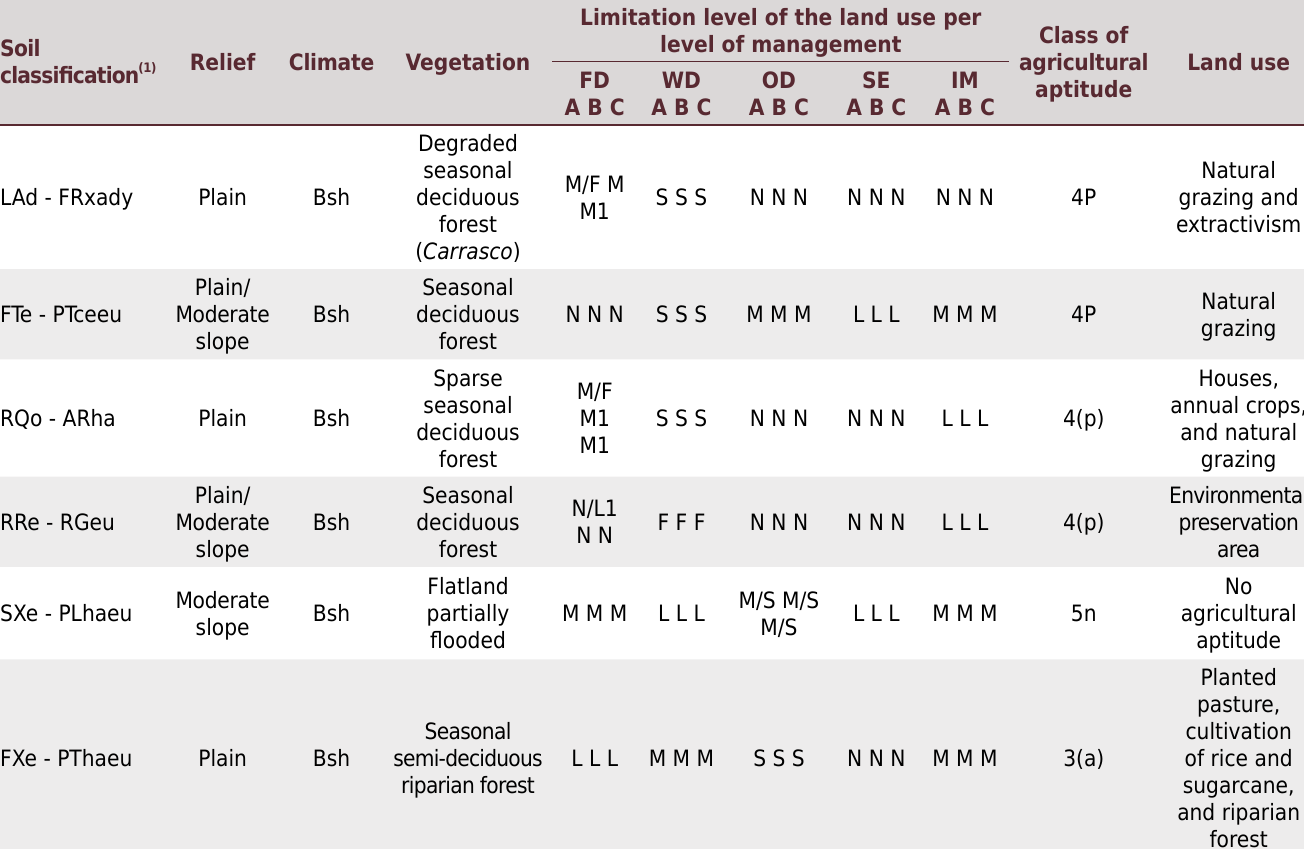
Table 4. Agricultural suitability evaluation and classification of land use - Malhada Grande, northern Minas Gerais, Brazil Soil classification